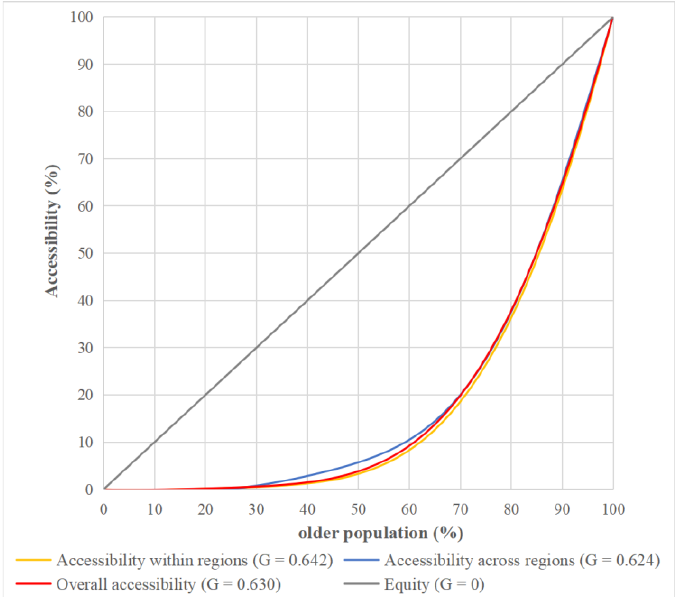
Figure 4. Social equity of accessibility to tertiary hospitals for older adults.